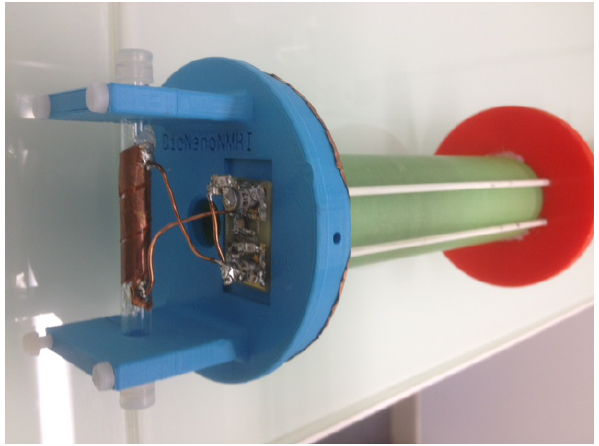
Figure 7. Photograph of the ribbon solenoid coil dedicated to spinal cord injury.